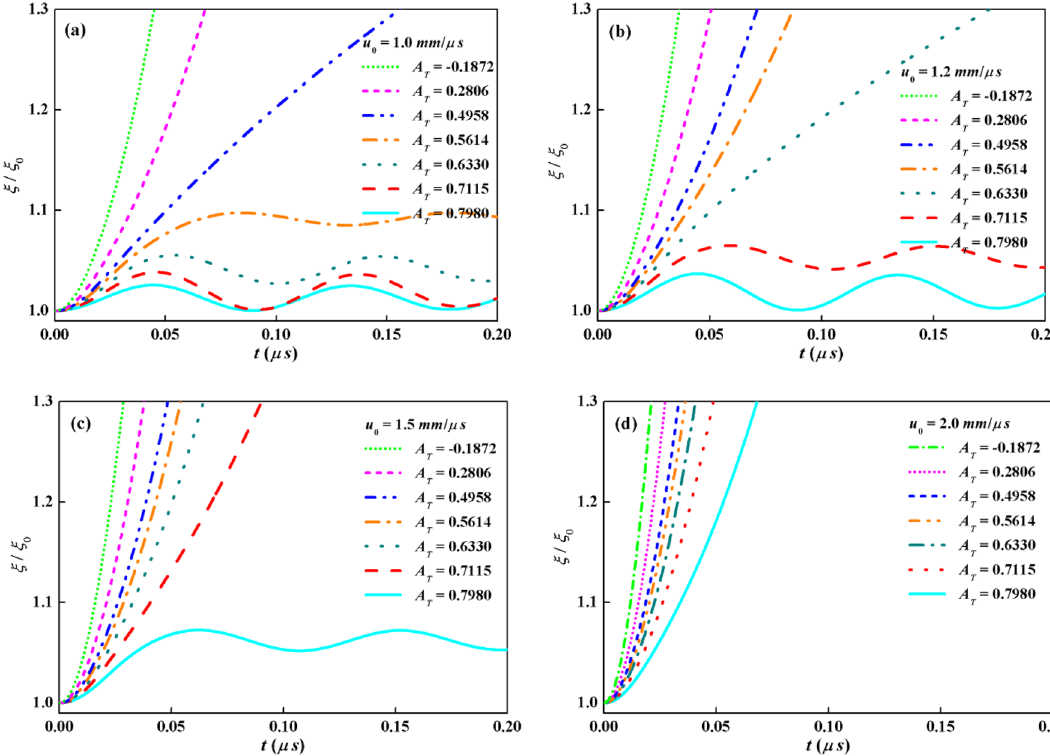
Figure 5. Growth factors vs time with A T = 0.7980, 0.7115, 0.6330, 0.5614, 0.4958, 0.2806 and − 0.1872 at u 0 by analytical model: ( a ) u